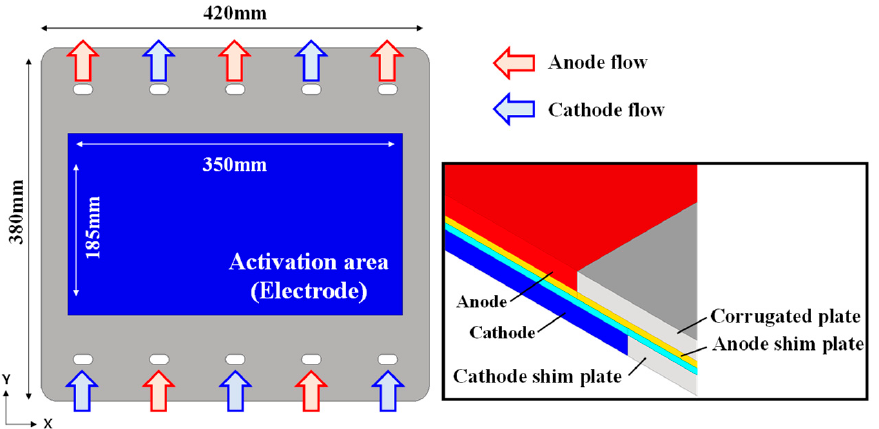
Figure 4. Schematic diagram of the internal manifold-type MCFCs for simulation.